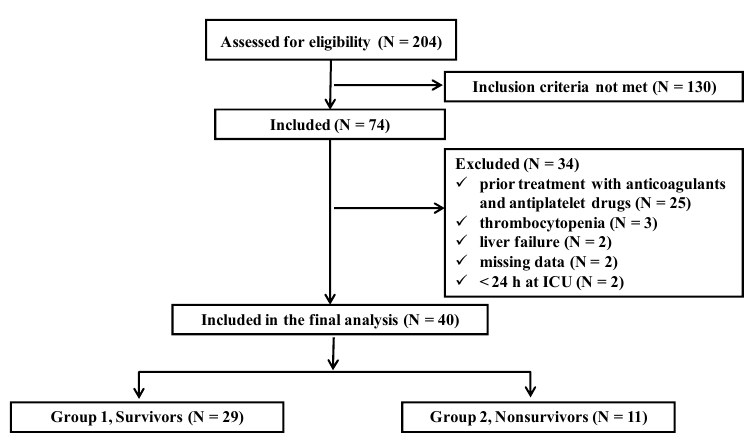
Figure 1. Flow diagram of the study. ICU, intensive care unit.